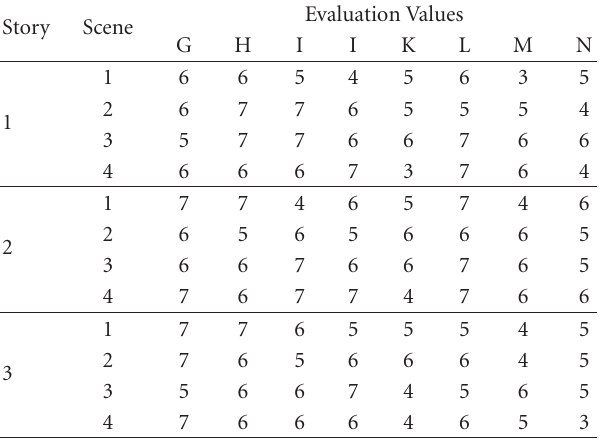
Table 4: Evaluation